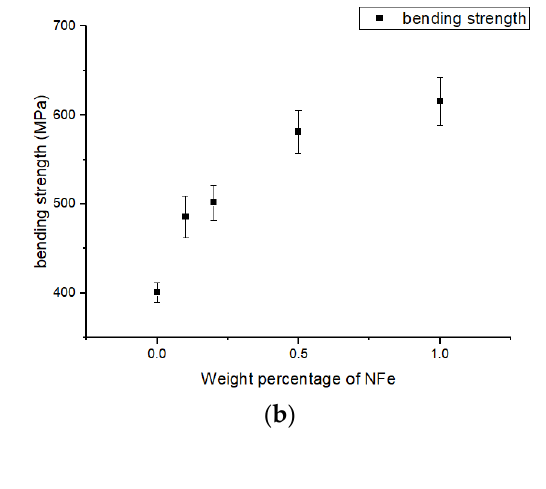
Figure 6. Load vs. deflection graphs of bending tests for modified GFRP with ( a ) MWCNTs, ( b ) NFe, and ( c ) NS.